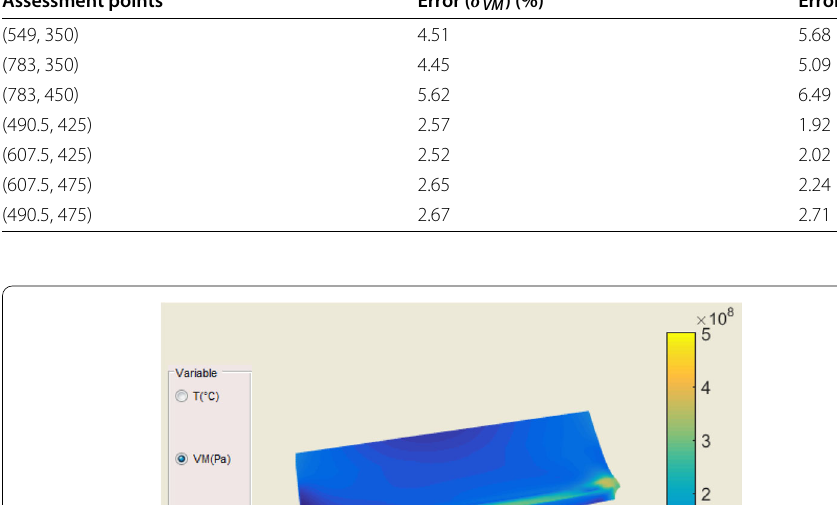
Table7 RB errors of von Mises stress and plastic strain in the 2D parameter space Assessment points